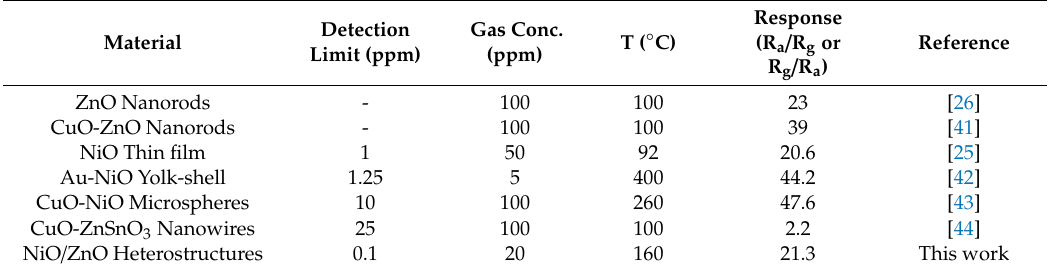
Table 1. Comparison of the H 2 S gas sensors based on various semiconductors.